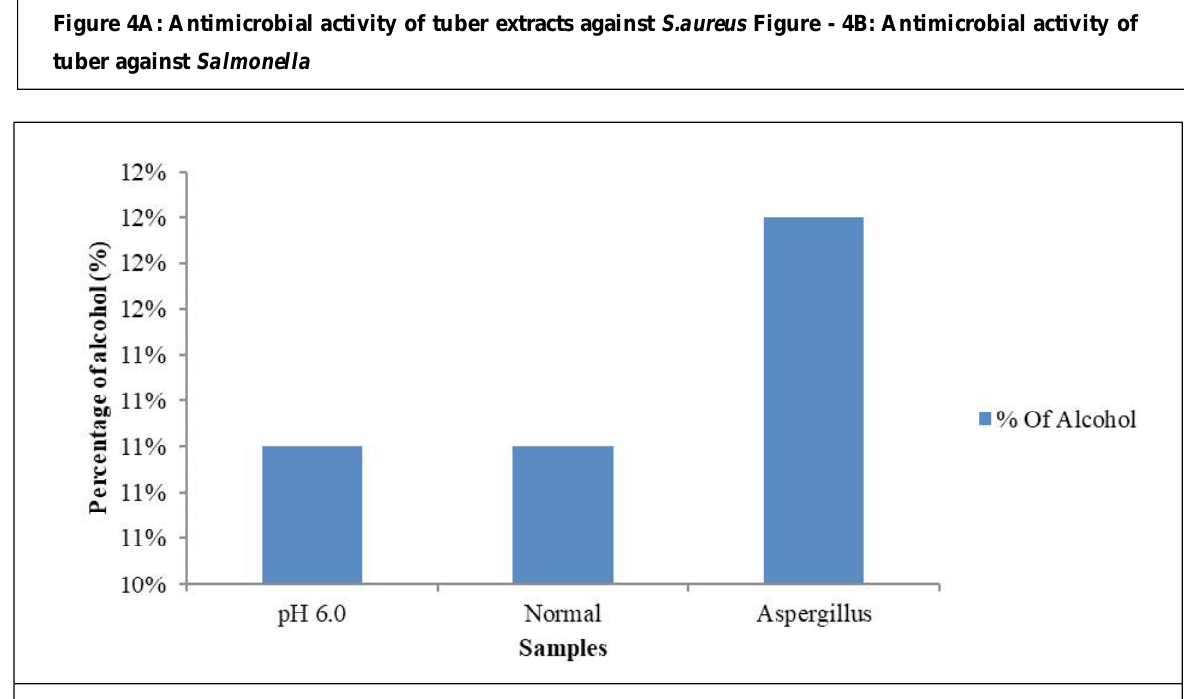
Figure 5: Percentage of alcohol produced from Amorphophallus commutatus after fermentation